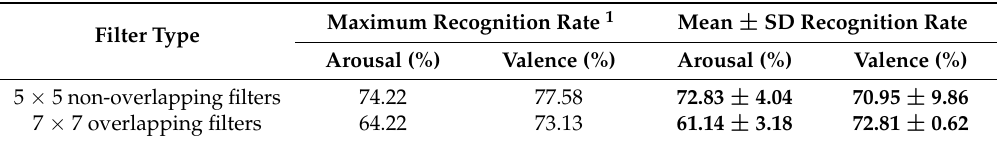
Table 3. Recognition rate results from different filter